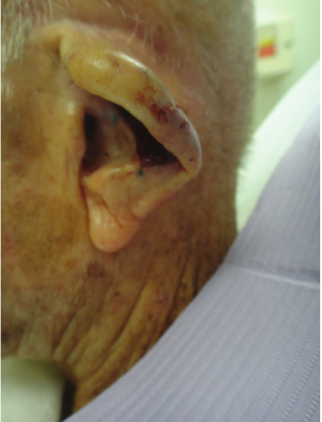
Figure 3: Lop-ear deformity.